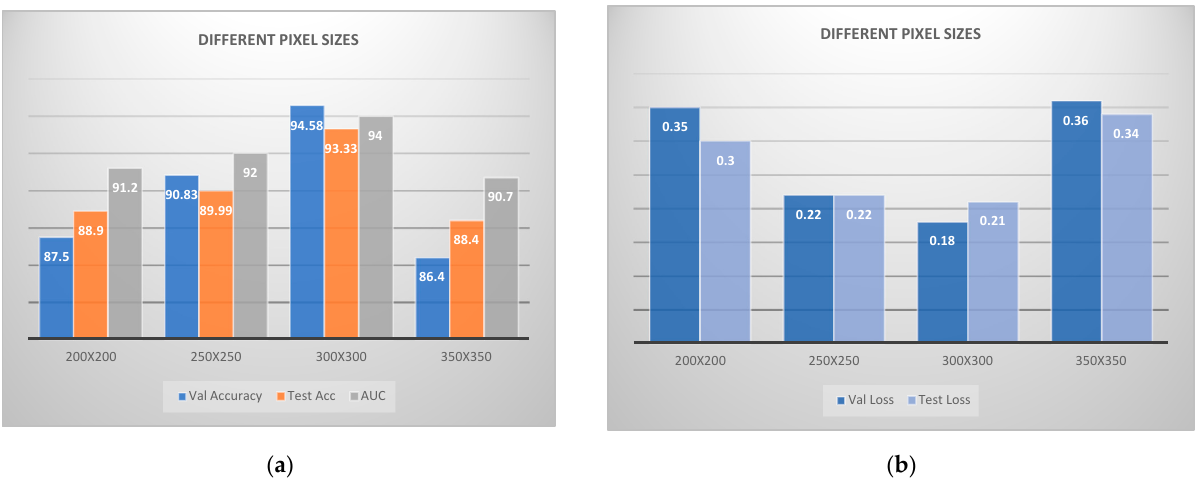
Figure 4. Convolutional neural network architecture for CAD classification problem comparing various pixel sizes: ( a ) accuracies; ( b ) losses.